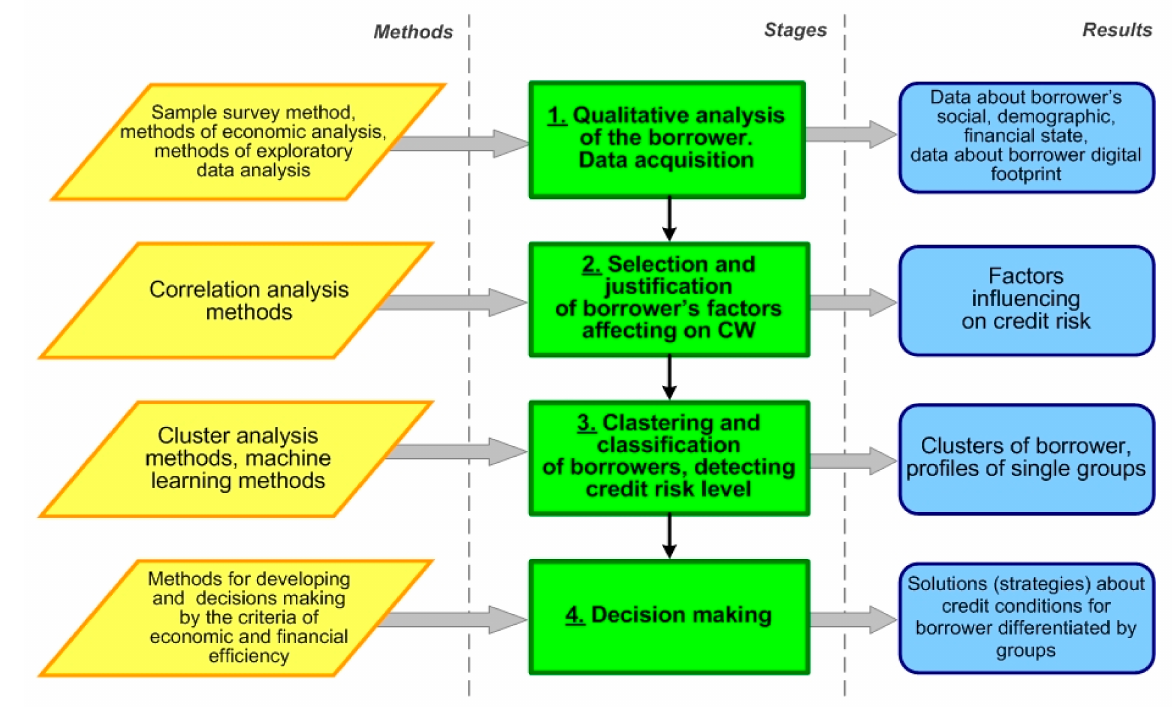
Figure 1. Conceptual scheme of the technology for individual creditworthiness (CW)